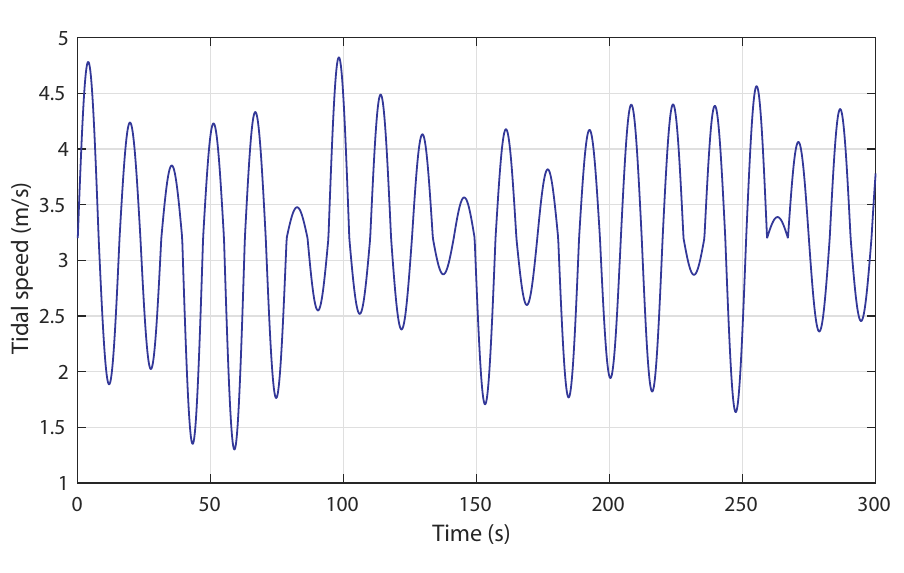
Figure 17. Scenario 2: Turbulent tidal speed input.